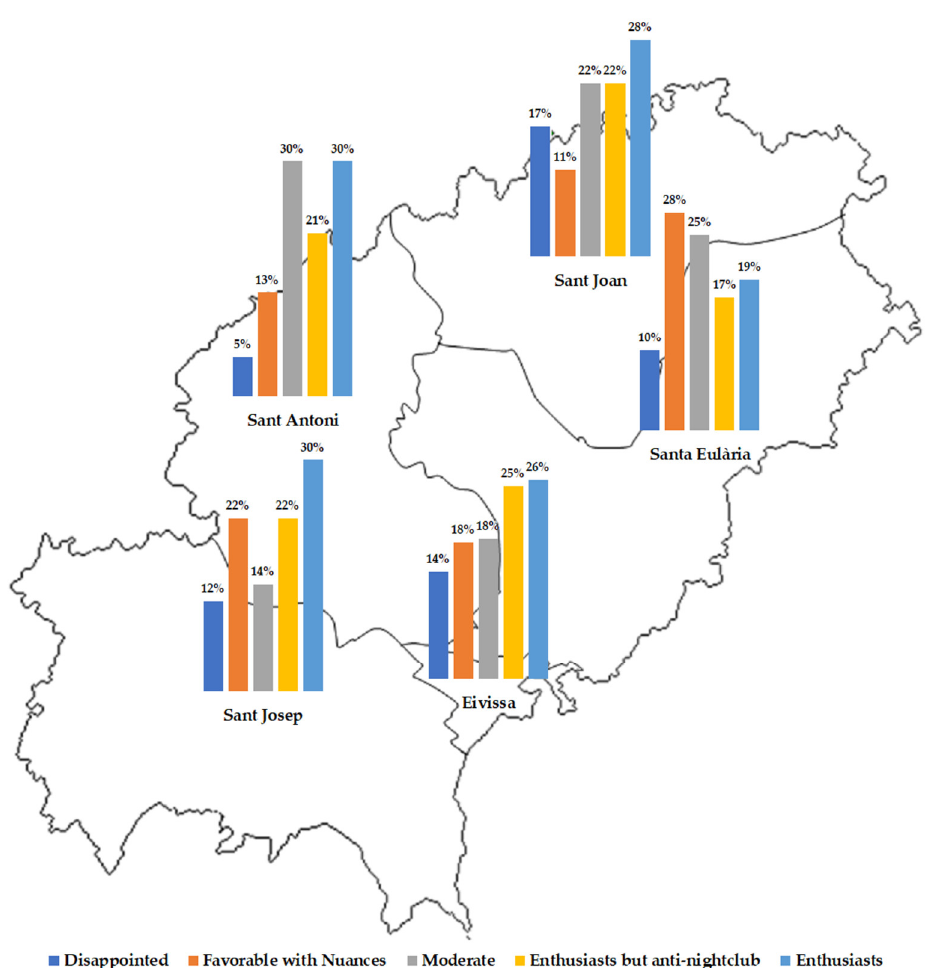
Figure 1. Profile by municipalities (source: own elaboration).